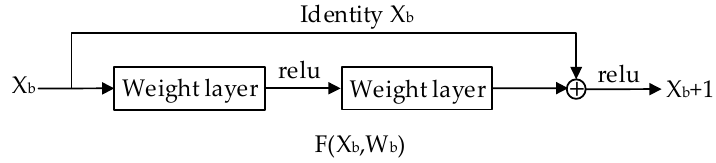
Figure 5. Residual unit.